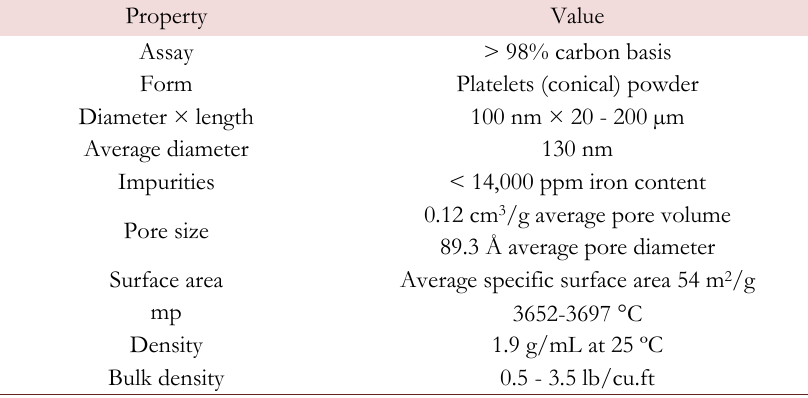
Table 3: Technical specifications of the CNFs used in this